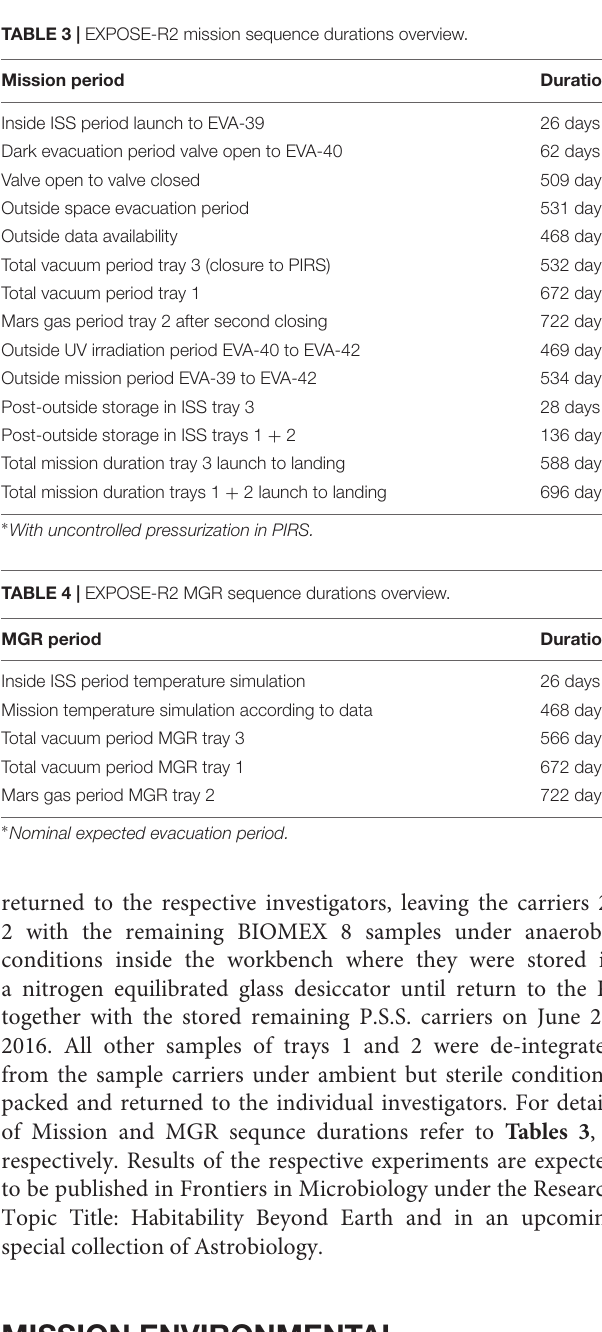
TABLE 3 | EXPOSE-R2 mission sequence durations overview.